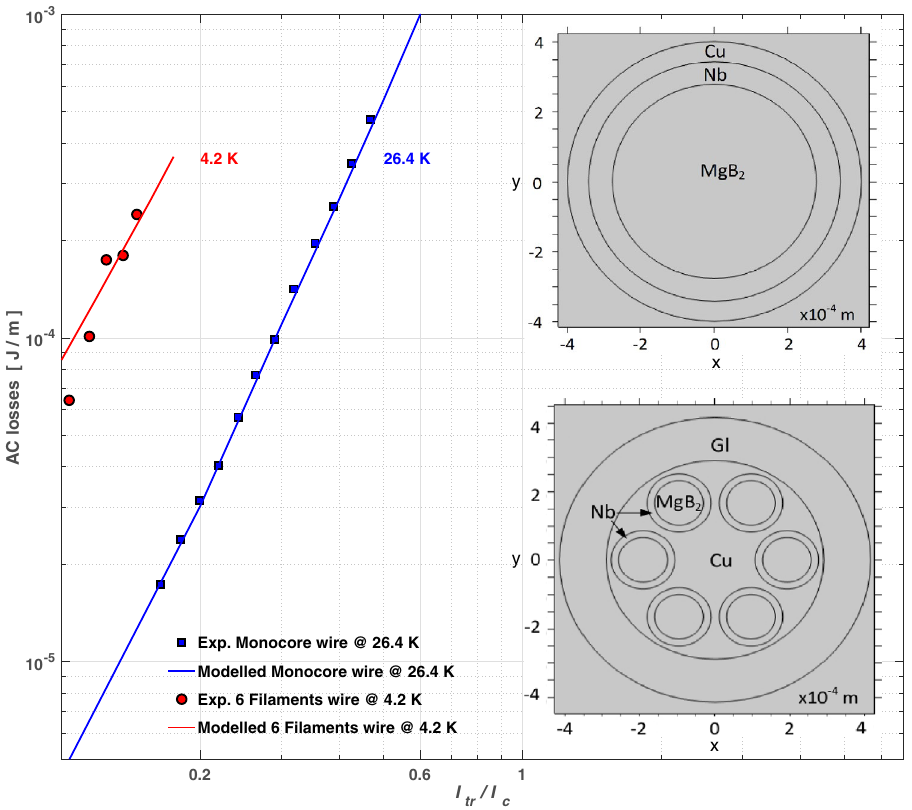
Figure 1. Calculated AC-losses for the MgB 2 monocore and multicore wires shown at the right-pane inset. Solid symbols correspond to the experimental measurements at 26.4 K for the monocore wire 59 , and 4.2 K for the six filaments multifilamentary (multicore) wire 60